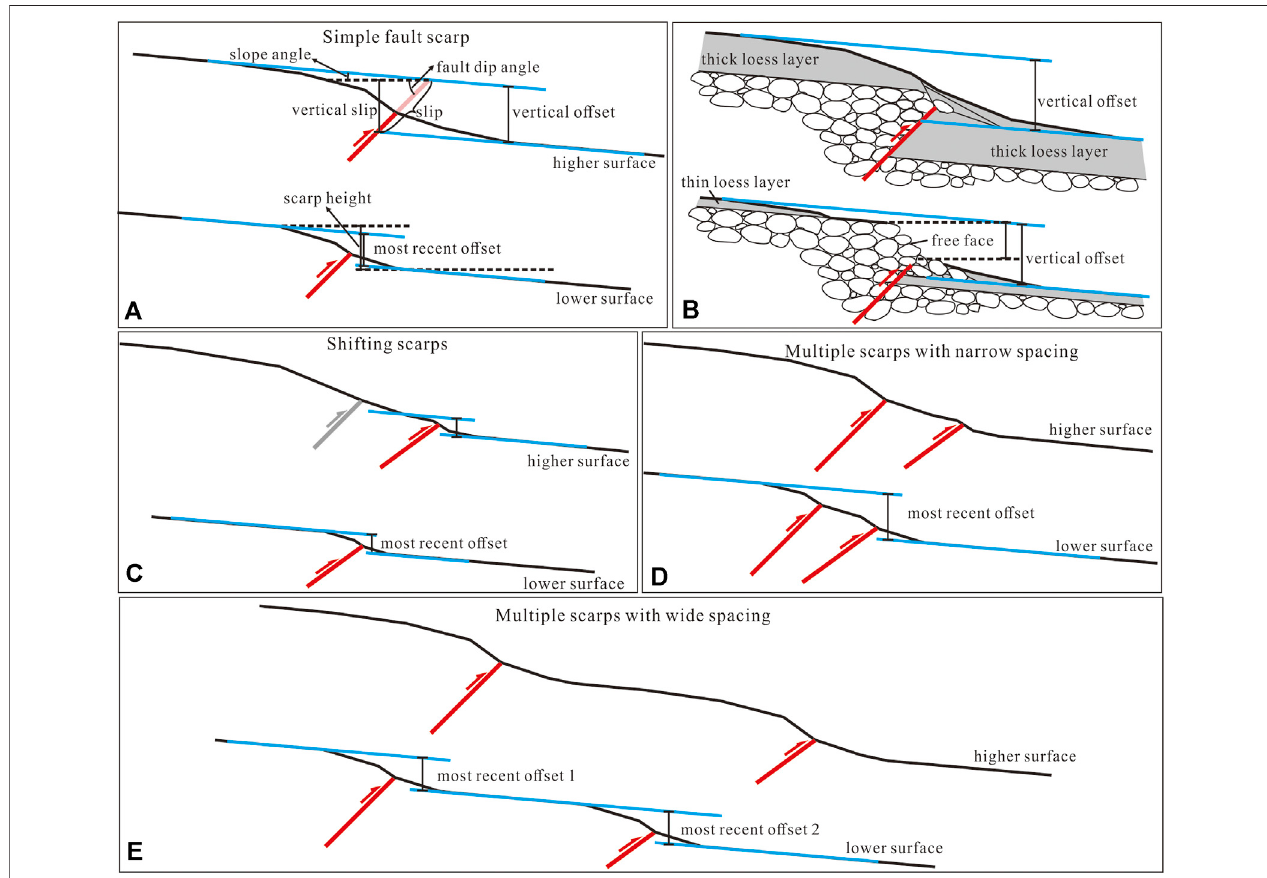
FIGURE 3 | Scarp types of the 1609 earthquake. (A) Simpli fi ed model for the simple fault scarp. The upper fi gure shows a higher and older scarp on an older and higher surface, and the lower one is a lower scarp on a young surface. The vertical slip is very close to the vertical offset ofthe surface according to the upper fi gure, and the scarpheightissimilar but slightlylargerthan theoffset accordingtothelower fi gure. (B) The freefaceispronetoremain onthesurface,which ismainlycomposed of gravels with minimal loose cover, and its height isapproximate to the vertical offset. (C) Simpli fi ed model for shifting scarps. A steepand lower scarp occurs on the hillslopeofanoldermodi fi edscarponthehighersurface,whileonlyonescarpoccursontheadjacentlowersurface. (D) Multiplescarpswithnarrowspacing,lessthana hundred meters, can be pro fi led on the young surface to achieve the most recent offset. (E) Multiple scarps with wide spacing, more than hundreds of meters. We summed up all offsets across each scarp on the young surface to obtain the total vertical offset of the most recent earthquake.